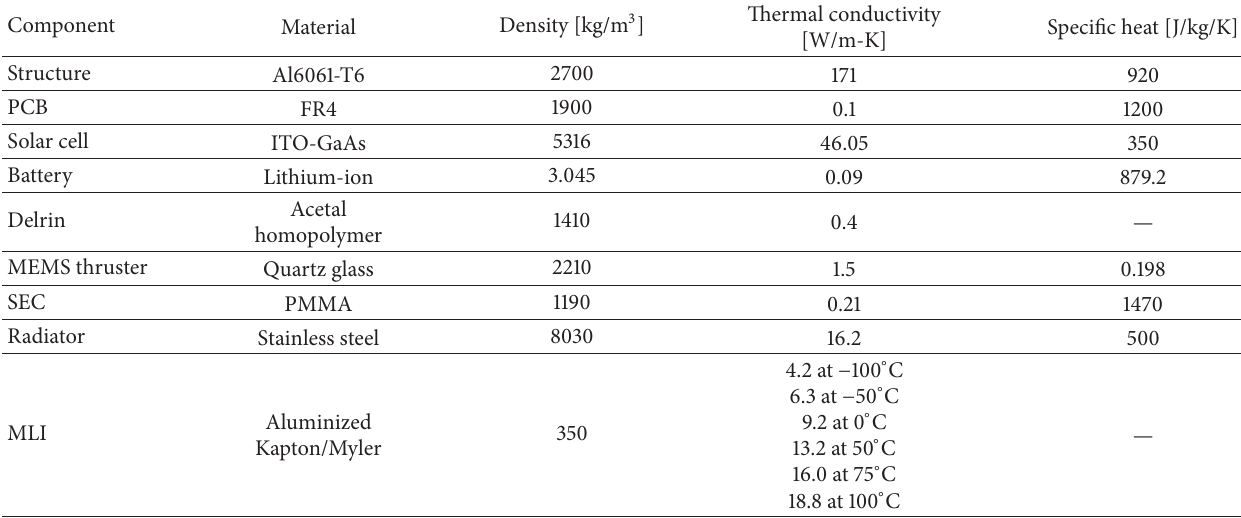
Figure 9: Orbit profile of STEP Cube Lab with permanent magnet stabilization strategy ((a) view from the orbit normal direction, (b) view from the sun). Table 5: Summary of material properties used in the analysis.